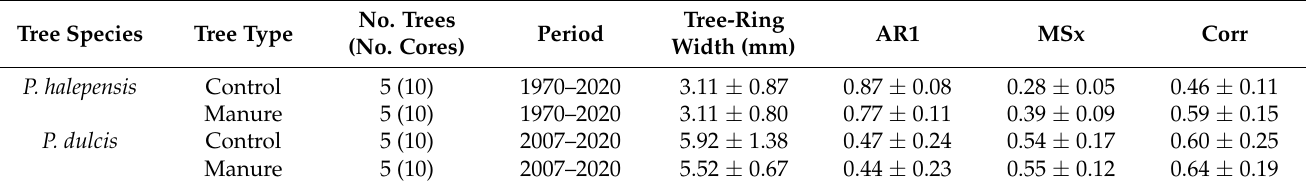
Tree Species Tree Type